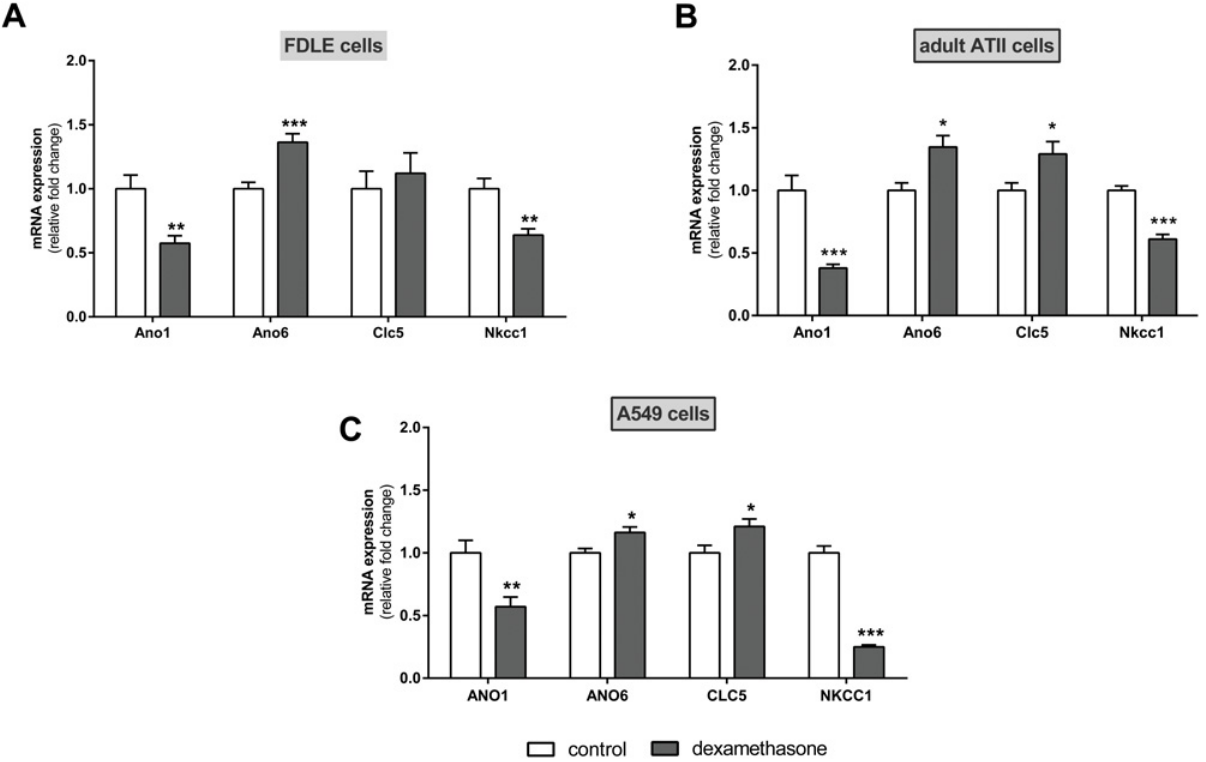
Fig 9. Dexamethasone modulates alternative chloride transporters in alveolar cells. Graphs represent the mean + SEM for normalized mRNA expression in response to 100 nM dexamethasone for 24 h acquired by RT-qPCR. A: FDLE cell monolayers (n = 7 – 12, ** p < 0.01, *** p < 0.001, T-test compared to control monolayers without dexamethasone addition). B: Adult ATII cells (n = 4 – 6, * p < 0.05, *** p < 0.001, T-test compared to control monolayers without dexamethasone addition). C: A549 cells (n = 8 – 12, * p < 0.05, ** p < 0.01, *** p < 0.001, T-test compared to control cells without dexamethasone addition).